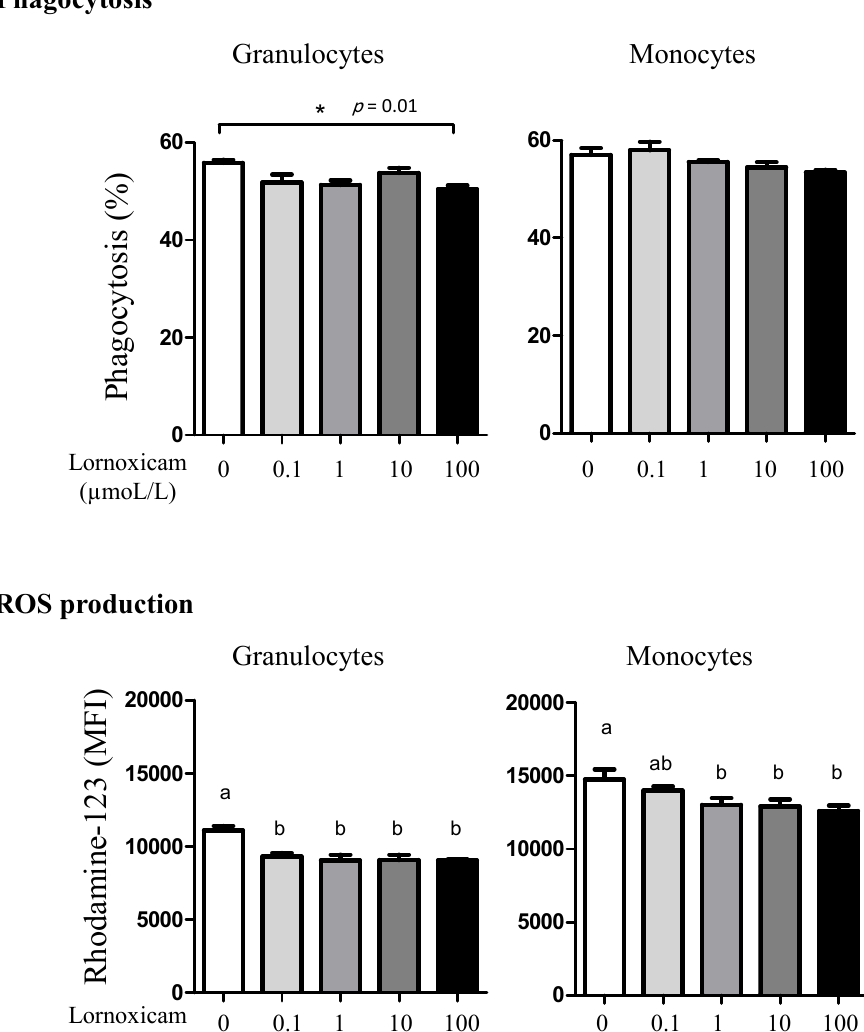
Figure 9. The impact of in vitro incubation with lornoxicam on phagocytosis and ROS production by camel granulocytes and monocytes. ( A ) Leukocytes were stimulated with FITC-labeled bacteria and the percentage of cells with ingested bacteria was determined by flow cytometry. * indicates significant differences between the means. ( B ) Impact of in vitro incubation with lornoxicam on ROS production by S. aureus -stimulated camel granulocytes and monocytes. Leukocytes were incubated with killed bacteria and dihydrorohdamin-123 (DHR-123) dye. Statistically significant differences between the treatments were measured using the one-way ANOVA (different lower case letters indicate a p < 0.05).